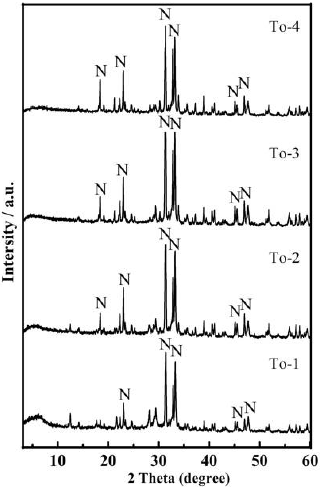
Figure 2. XRD pattern of products synthesized at different Ca/Si molar ratio at 160 °C for 12 h. N—NaCaHSiO 4.